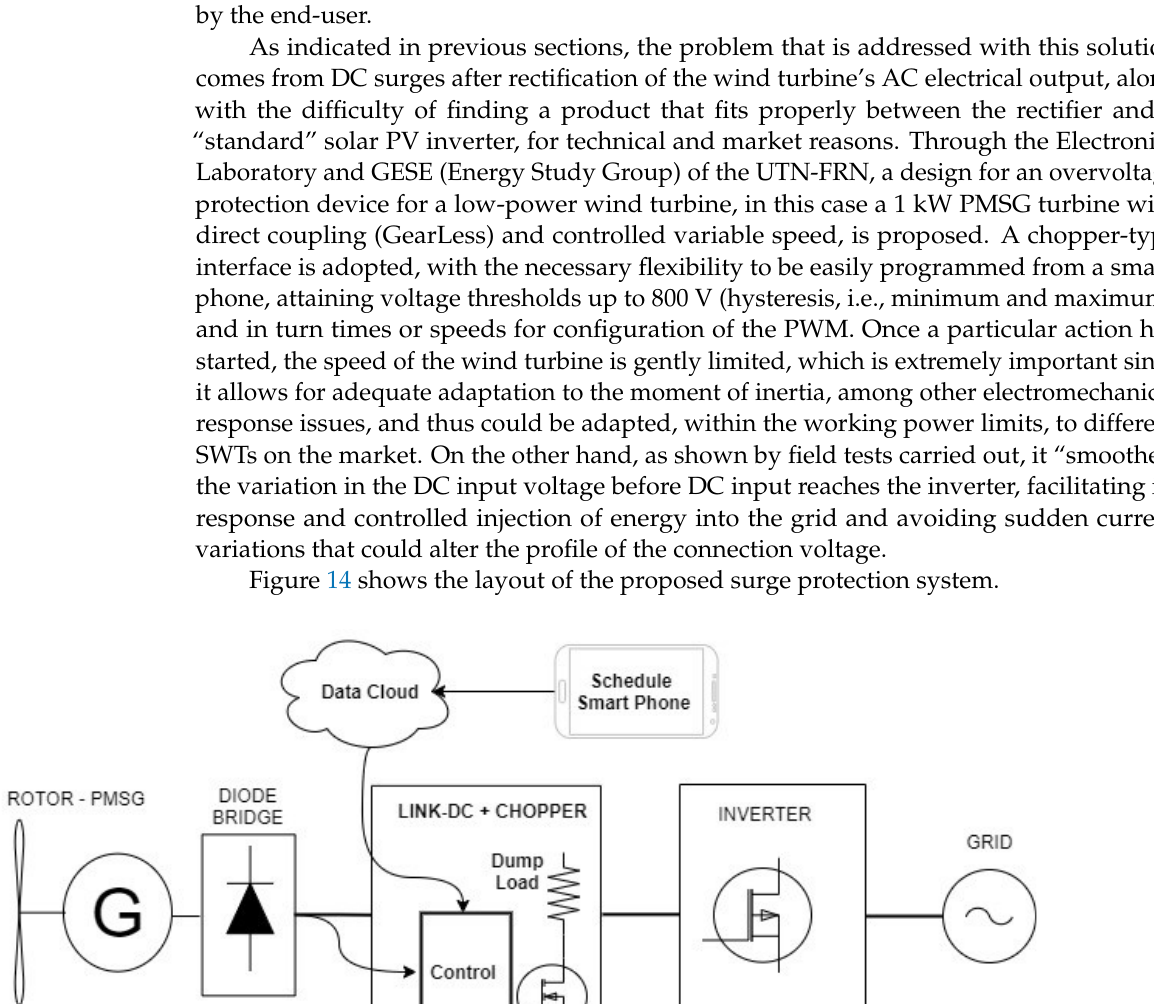
Figure 15. ( a ) Flowchart of the PWM chopper interface, ( b ) response curve according to voltage and time settings.